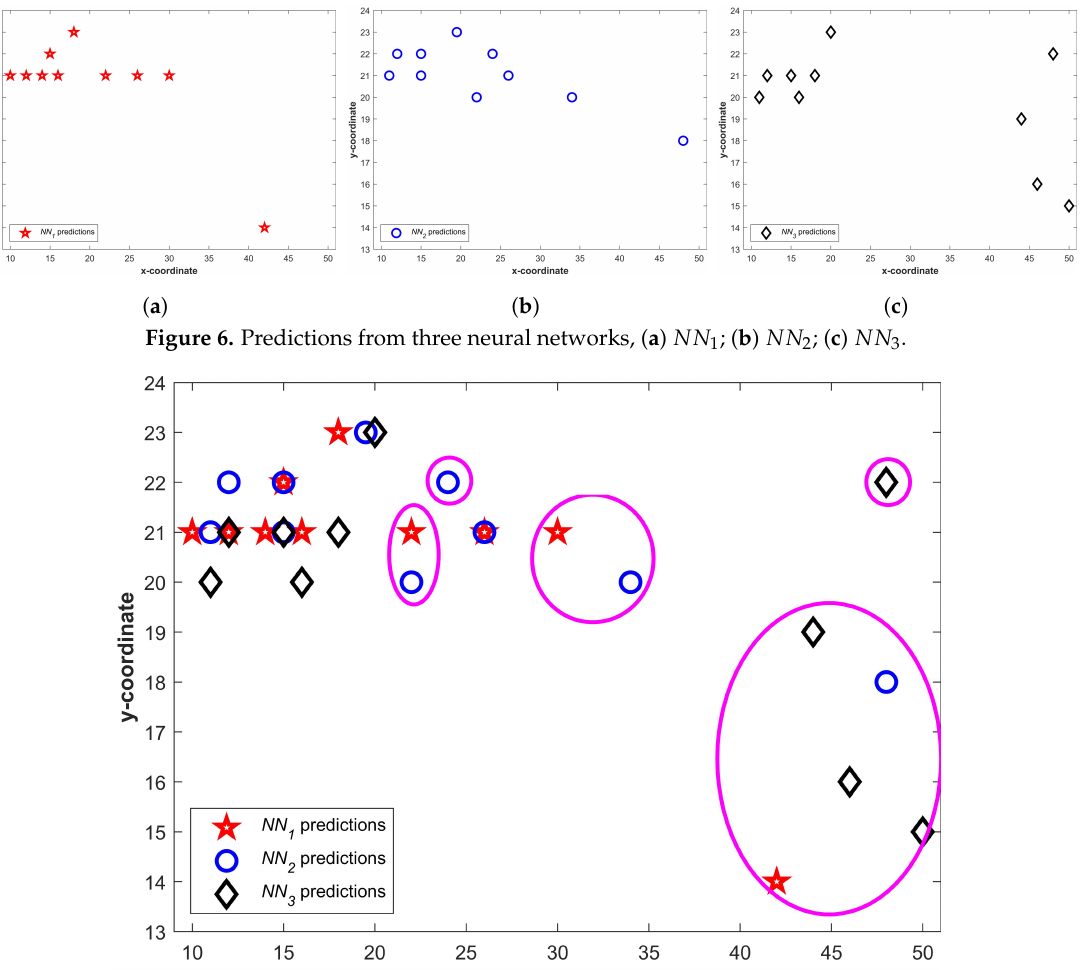
Figure 6. Predictions from three neural networks, ( a ) NN 1 ; ( b ) NN 2 ; ( c ) NN 3 .